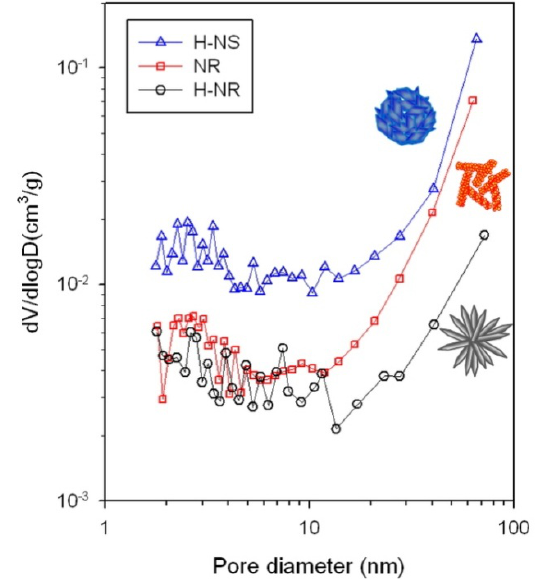
Figure 10. Pore size distributions of heat-treated H-NS, NR, and H-NR ZnO nanostructures determined from the nitrogen adsorption-desorption